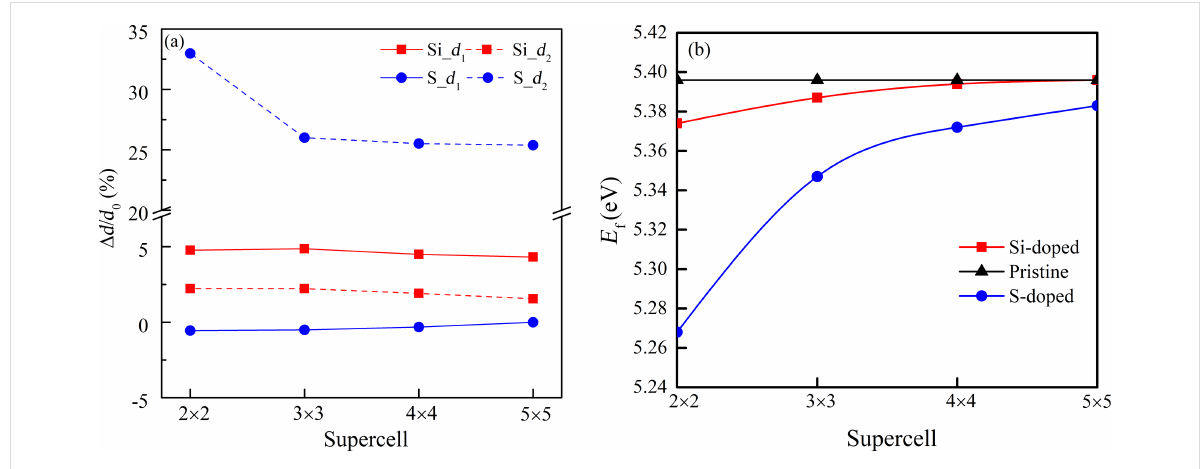
Figure 1: (a) Deviation of in-plane and out-plane bonds, d 1 and d 2 , respectively, and (b) formation energy E f as functions of the in-plane size of the supercell.